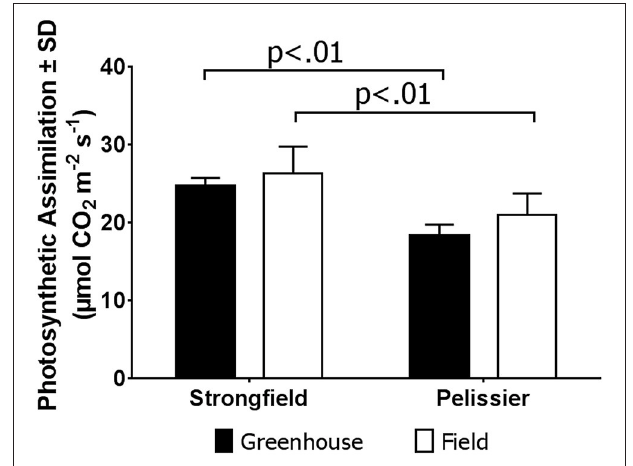
FIGURE 4 | Carbon assimilation rate in Strongfield and Pelissier plants. The flag leaf of well watered plants in greenhouse and plants without any obvious